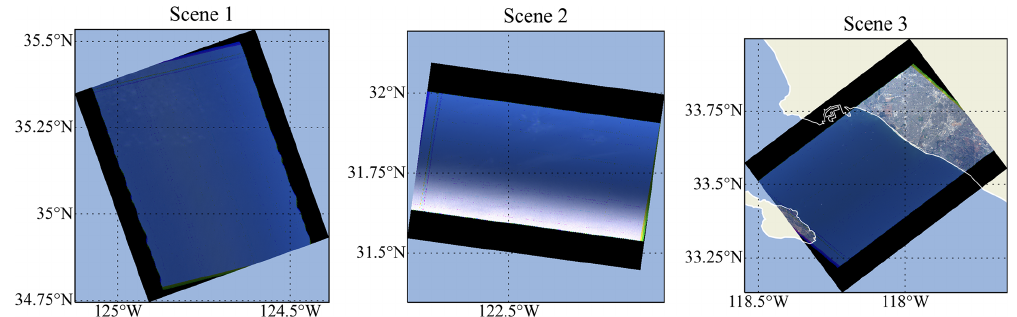
Figure 13. The RGB images (670, 550, and 440nm bands) for the three scenes at near-nadir viewing directions. Scene 1 and Scene 2 observe only ocean, while Scene 3 observes both ocean and land. Sparse thin clouds are visible from Scene 1 and Scene 2. Sunglint can be observed at the lower portion of the Scene 2